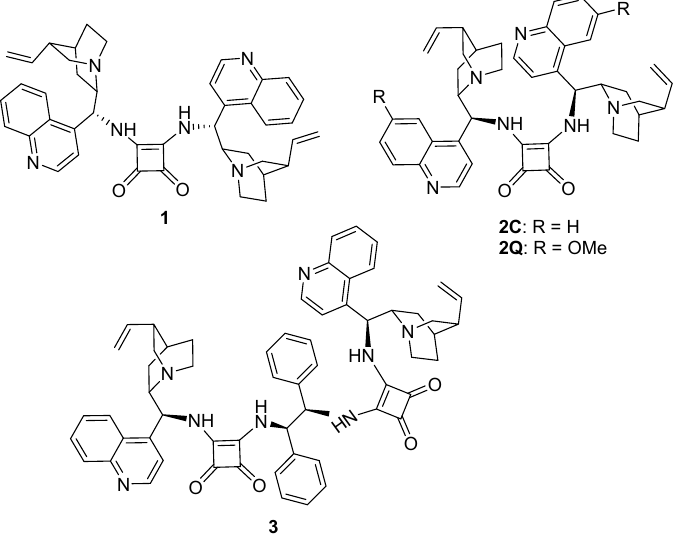
Figure 1. Dimeric cinchona squaramides 1 – 3 .